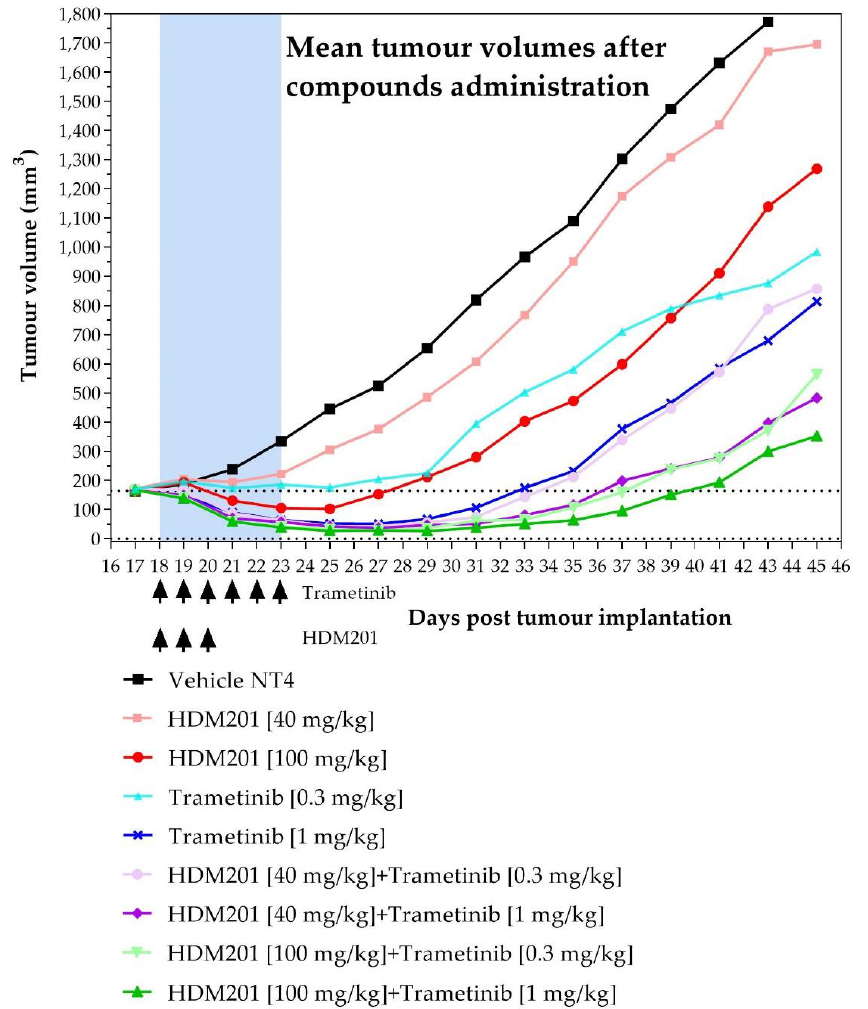
Figure 9. In vivo efficacy of HDM201 and Trametinib administered separately and in combination against a mouse model of human melanoma tumour (A375). HDM201 was dosed in a qdx3 schedule and Trametinib in a qdx6 schedule. Observed data are means from n = 6. Table 7. Mean tumour growth inhibition (TGI) values with standard error of mean (SEM) as metrics of in vivo efficacy of HDM201, Trametinib, and their combination in A375-inoculated CD-1 nude mice n = 6.